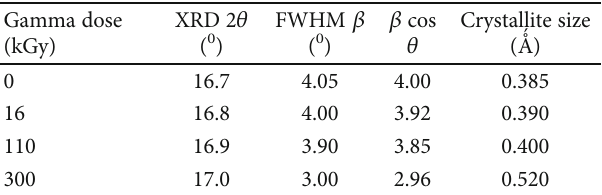
Figure 5: XRD patterns of virgin and gamma-irradiated UHMWPE polymer at various doses. Table 2: XRD parameters for virgin and irradiated UHMWPE polymer at various